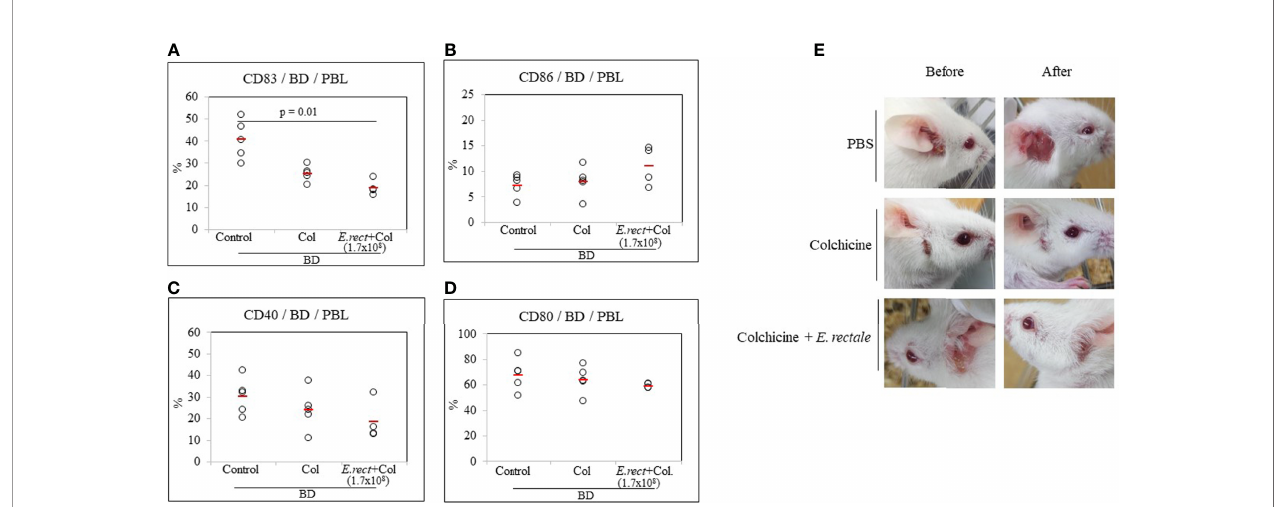
FIGURE 7 | The frequency of DC activation markers in BD mice after the administration of colchicine alone or in combination with E. rectale . The frequency of CD83, CD86, CD40, and CD80 on the surface of PBL of BD mice was evaluated by FACS analysis (A – D) . Changes in symptoms after treatment (E) . The p-value was determined by the Kruskal-Wallis test.